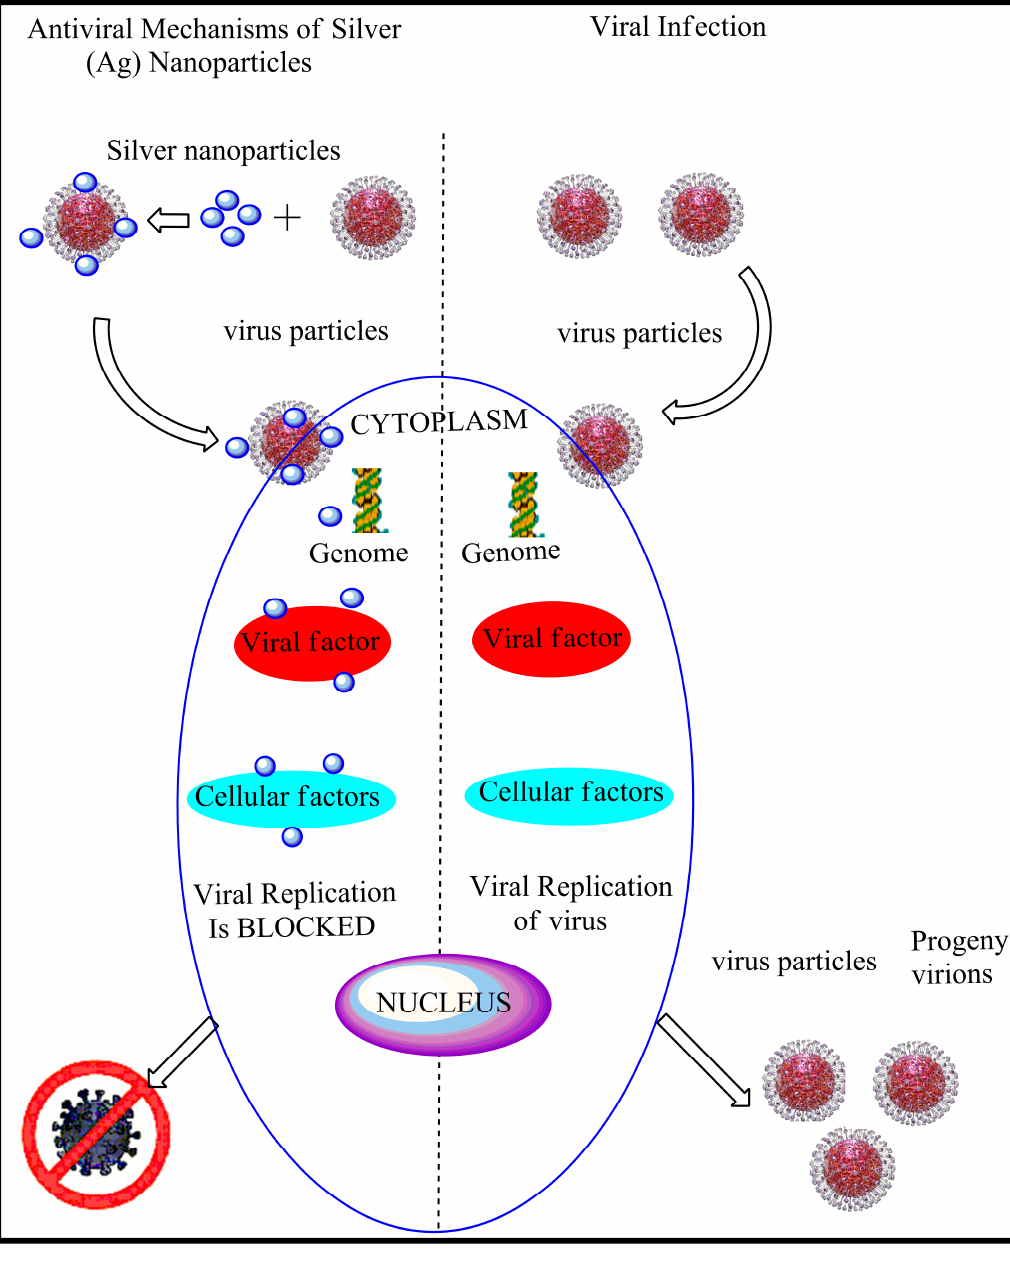
Figure 3. The antiviral activities of silver nanoparticles.